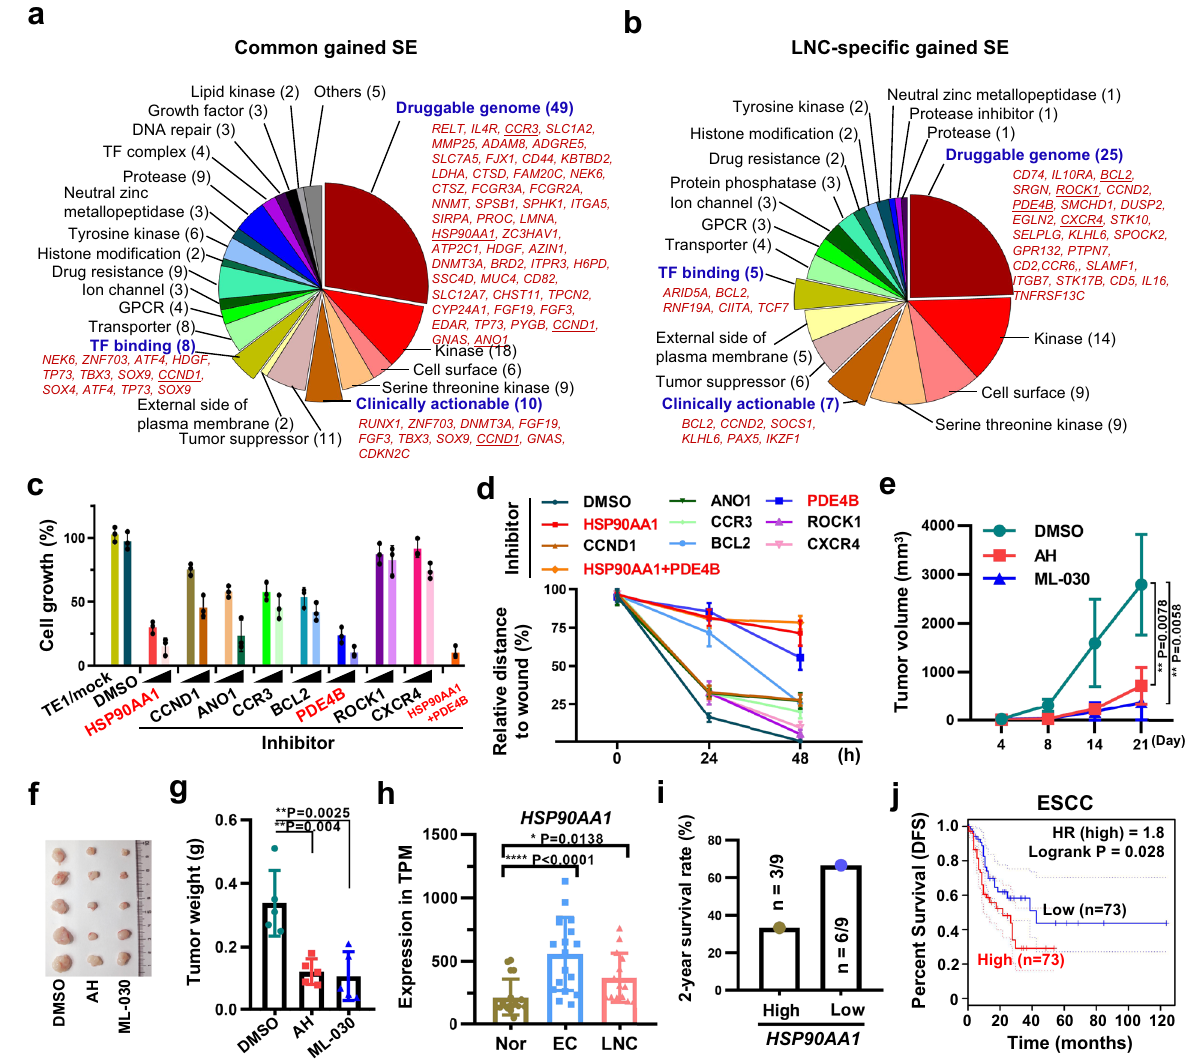
Fig. 5 Active regulatory super-enhancers predict candidate drugs against esophageal carcinogenesis and metastasis. a , b Pie charts showing candidate drug compounds detected through the integrated analysis of common gained ( a ) and LNC-speci fi c ( b ) super-enhancers with the Washington University Drug Gene Interaction Database. Three categories are highlighted in red. c TE1 cells were treated with eight chemical inhibitors separately or combinationally (AH + ML-030). Cells were counted at 72 h. Data were presented as mean values± s.d. n = 3 biologically independent experiments examined. d Wound healing assays for control and shRNA expressing TE1 cells. The wound width was examined every 24 h, and the wound width at 0 h was normalized to “ 1 ” , and the relative width to the width at 0 h was calculated. Data were presented as mean values± s.d. n = 3 biologically independent tumor volumes were determined ( e ). The tumors were collected from sacri fi ced mice on day 21 for image acquisition ( f ) and tumor weight